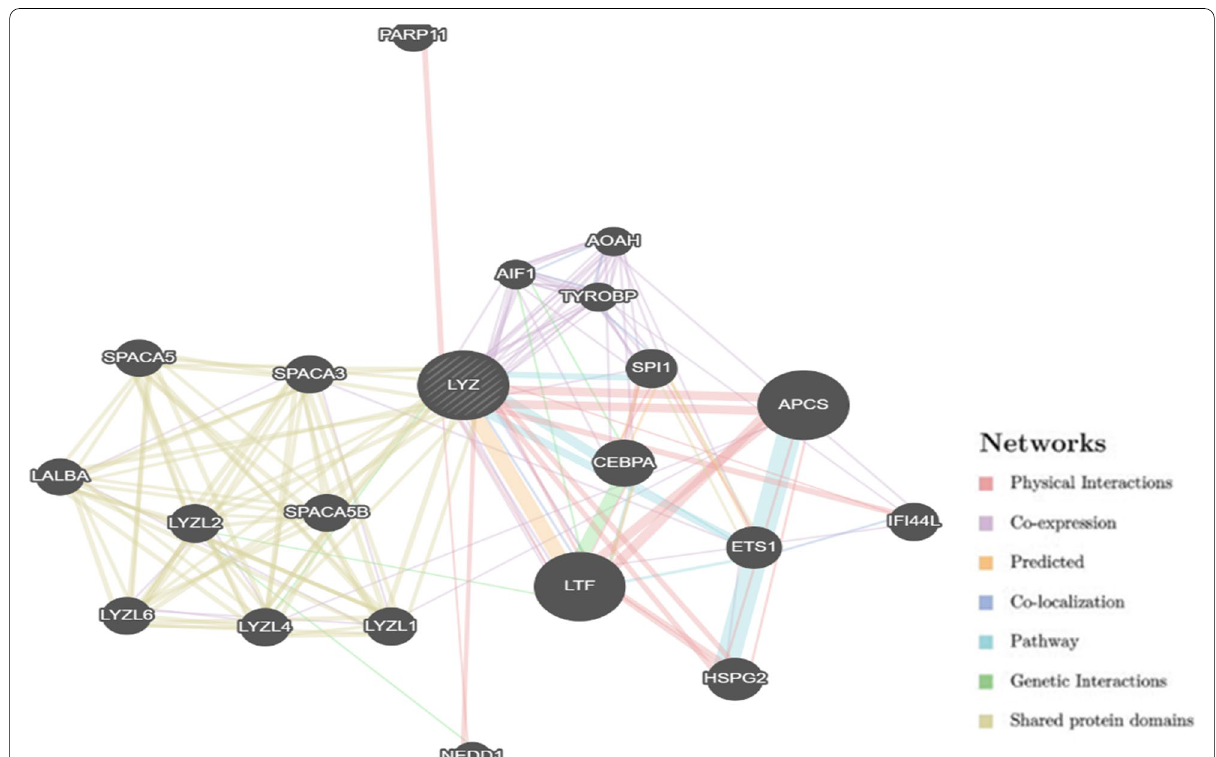
Fig. 1 Gene-gene interaction network of LYZ C gene predicted by